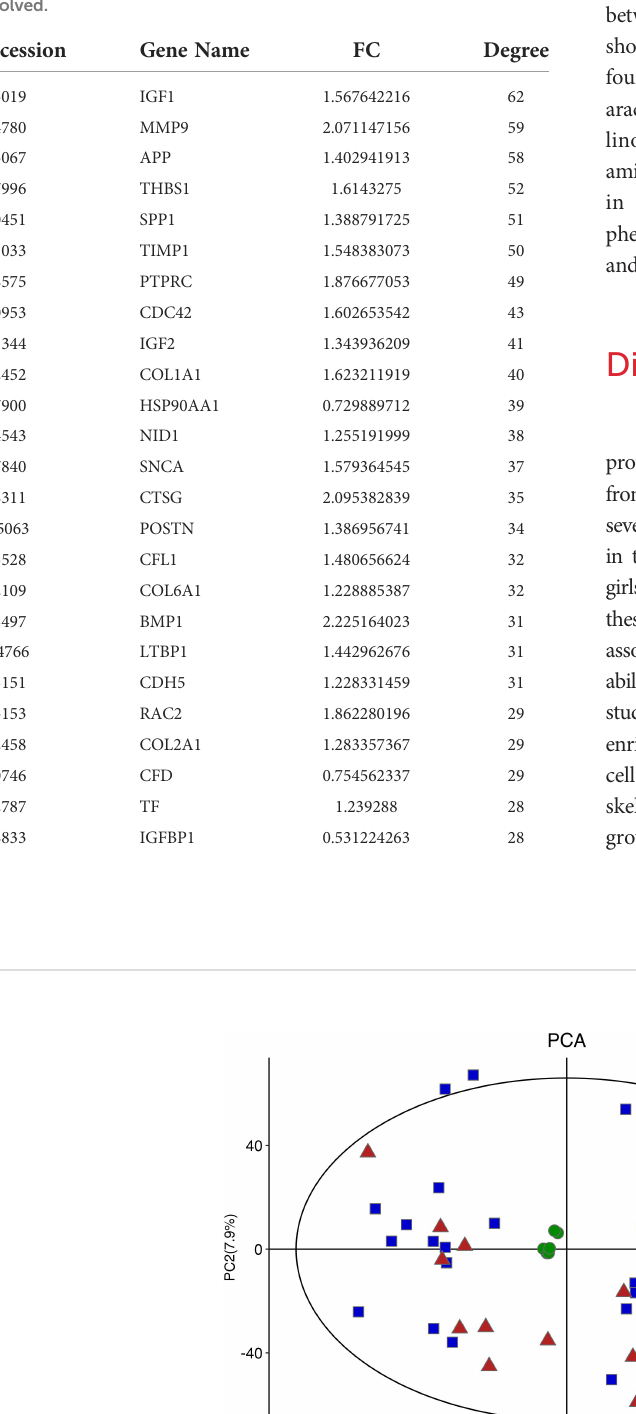
TABLE 2 A list of topological information of the network nodes involved.